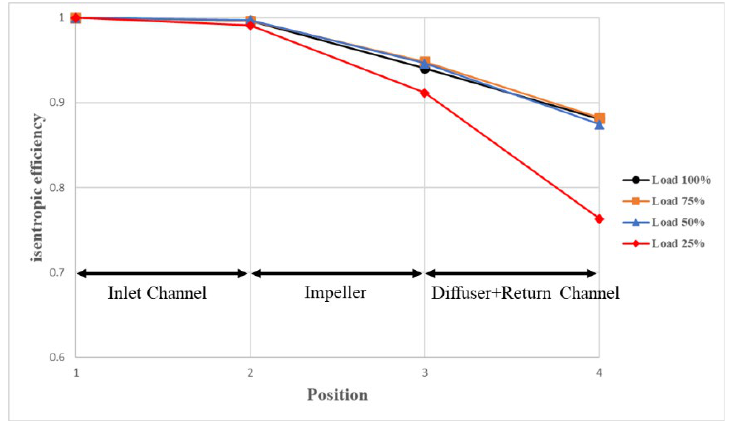
Figure 12. First stage isentropic compression efficiency comparison diagram with R-513A refrigerant in various flow element configurations.